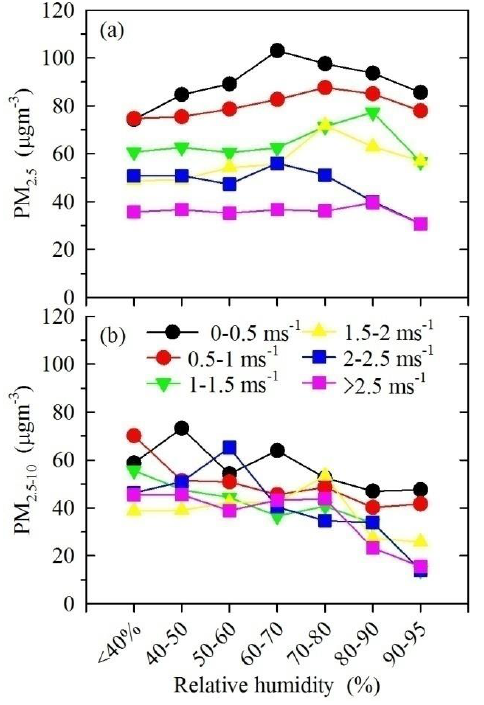
Figure 4 . The average concentrations of PM 2.5 ( a ) and PM 2.5-10 ( b ) at different ranges of relative humidity and wind speed. humidity and wind